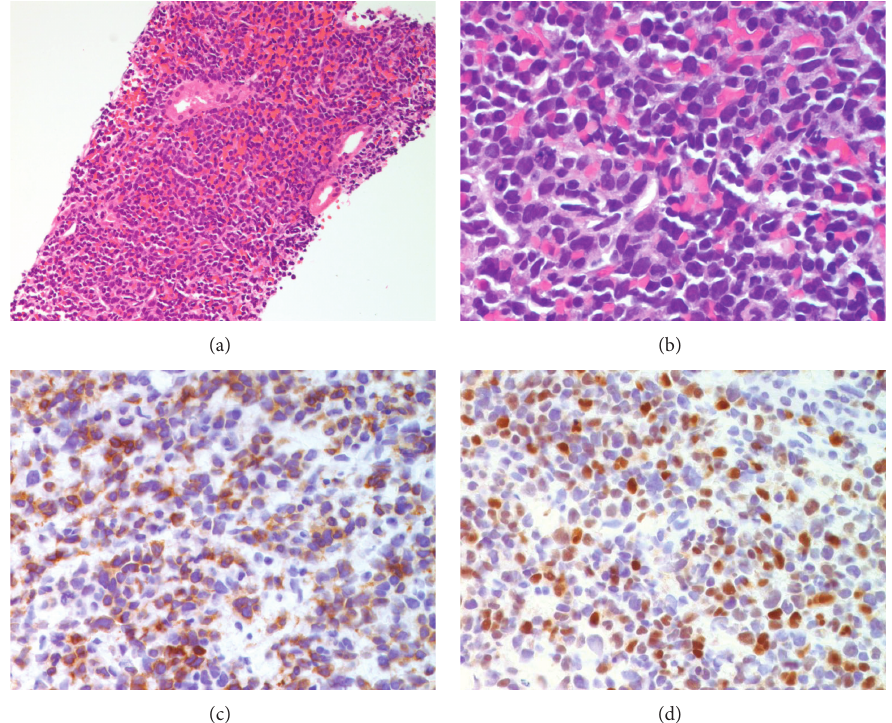
Figure 2: Kidney biopsy showing lymphoblastic infiltration. (a) Histology shows the interstitial lymphoblastic infiltrate surround- ing the glomeruli and tubules ( × 200 magnification). (b) Hematoxylin and eosin stain of the lymphoblasts ( × 630 magnification). (c) Immunohistochemistry with cells expressing CD79 with cytoplasmic staining ( × 400 magnification). (d) Immunohistochemistry with cells expressing TdT with nuclear staining ( × 400 magnification). These findings are typical of